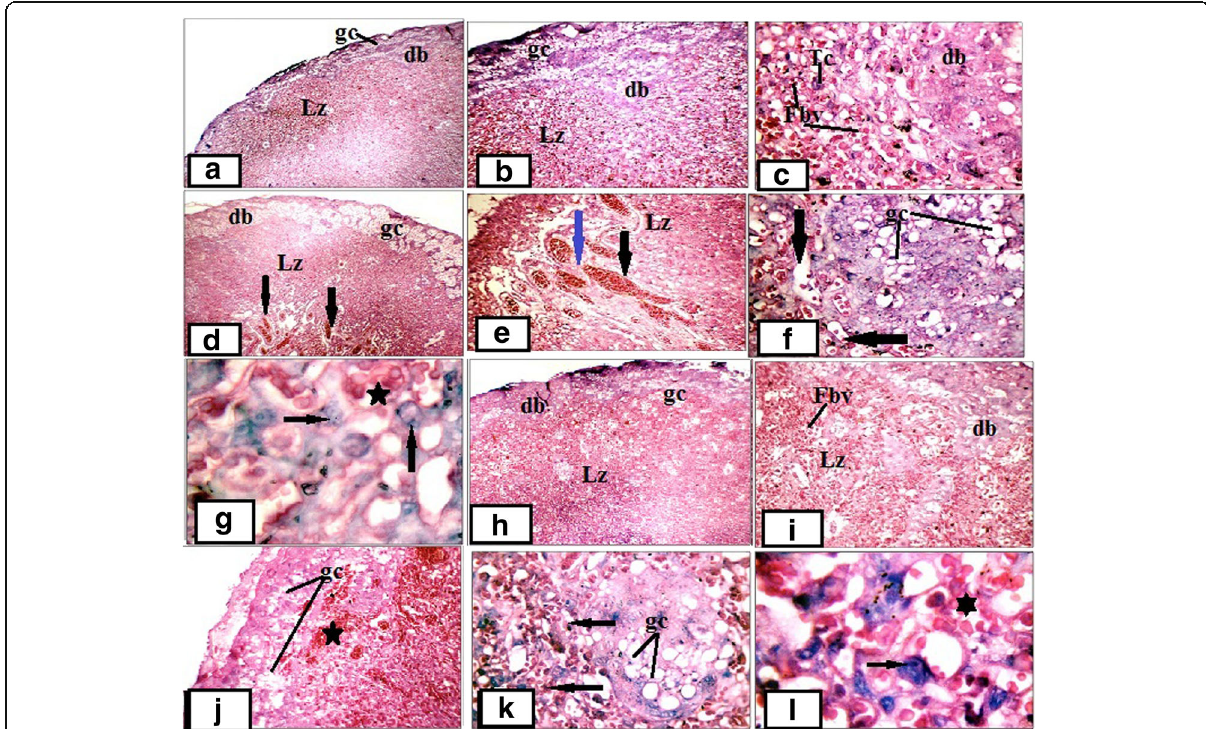
Fig. 5 Photomicrographs from placenta collected from mice of control and treated groups stained with H&E stain. The control placenta showing average decidua basalis (db), labyrinth zone (Lz), and glycogen cells (gc). The area of labyrinth zone showing fetal blood vessels (Fbv) and trophoblastic cells (Tc) ( a – c ) (H&E ×4, ×10, and ×40 respectively). d G II showing decreased area of decidua basalis (db), excess glycogen cells (gc) (H&E ×4) and labyrinth zone showing markedly congested blood vessels (arrows) with excess fibrin deposition (blue arrow) ( e ) (H&E ×10). f G II showing excess glycogen cells (gc) and dilated fetal blood vessels (arrows) (H&E ×40). The high power showing markedly congested fetal blood vessels (star) and some of trophoblastic cells showing pyknotic nuclei (arrows) ( g ) (H&E ×100). The placenta of GIII showing average decidua basalis (db), labyrinth zone (Lz), and glycogen cells (gc). The area of labyrinth zone showing fetal blood vessels (Fbv) ( h , i ) (H&E ×4 and ×10 respectively). The placenta of GIV ( j ) showing decidua basalis (db) with mild glycogen cells (gc) and markedly congested labyrinth zone (star) (H&E ×10). The area of labyrinth zone with some apoptotic cells (black arrows) ( k ) (H&E ×40), the higher power showing mild congested fetal blood vessels in labyrinth zone (star), with trophoblastic giant cell (arrow) ( l ) (H&E